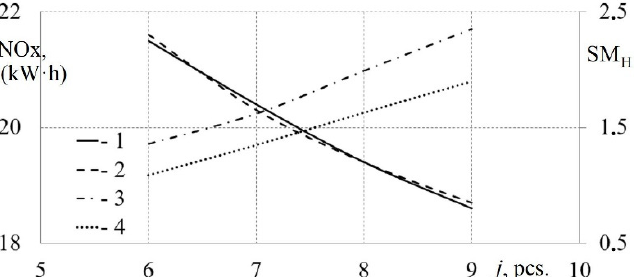
Figure 4. Dependences of the amount of NOx emissions and smokiness of the exhaust gases SMH on the number of holes j in the nozzle of the diesel injector at different modes: 1—NOx = f ( j ) at the nominal engine mode; 2—NOx = f ( j ) at idle; 3—SM H = f ( j ) in the nominal mode; 4—SM H = f ( j ) at idle.